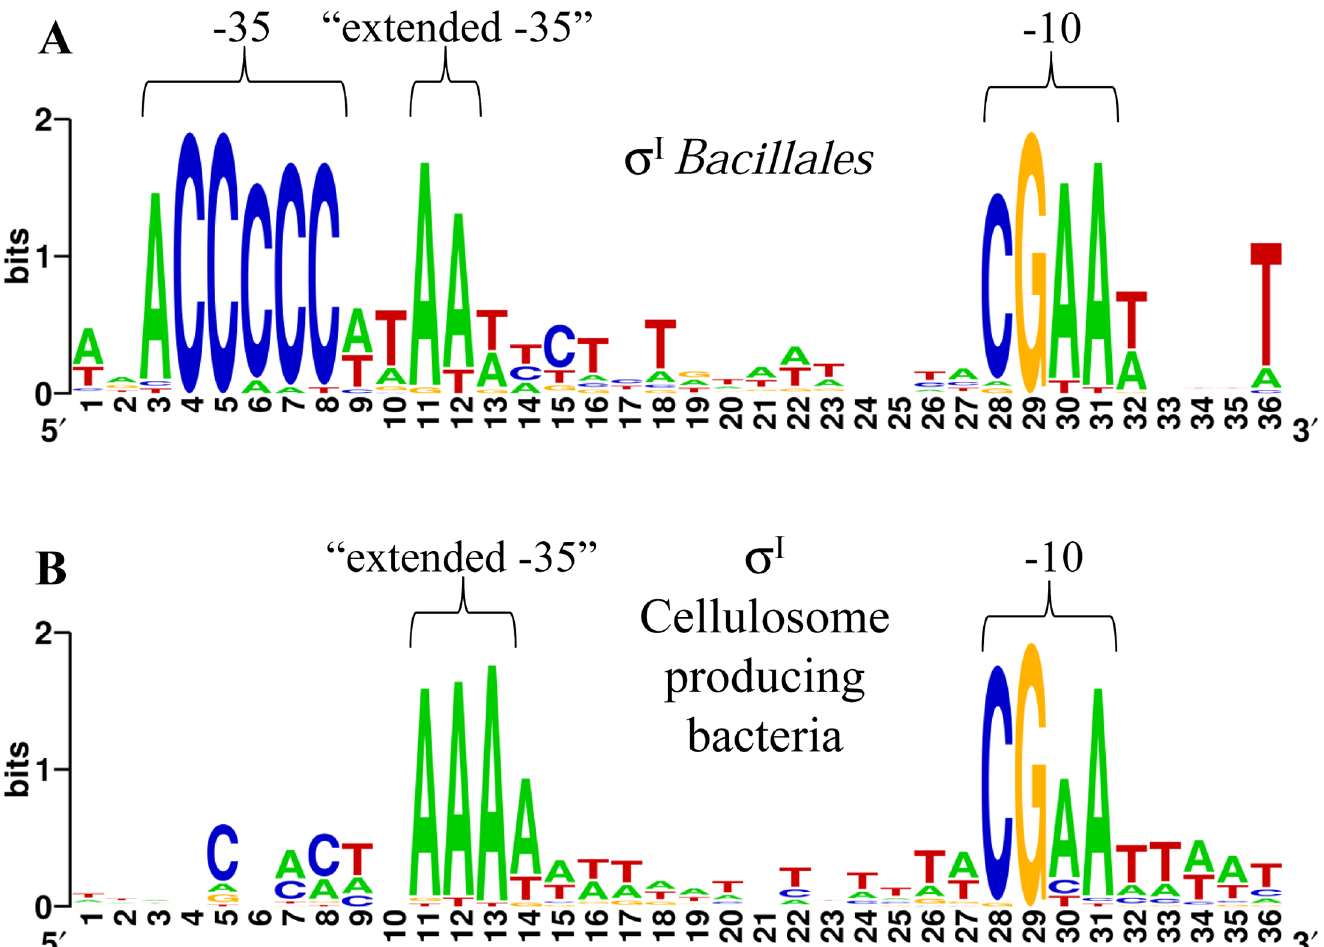
Fig 1. Identification of conserved elements of σ I -dependent promoter sequences. (A) WebLogo generated with the Bacillales sigI promoters shown in S4 Table. (B) WebLogo generated with the C . thermocellum and C . straminisolvens sigI promoters shown in Table 1, and the C . clariflavum , A . cellulolyticus and Pseudobacteroides cellulosolvens sigI promoters shown in S5